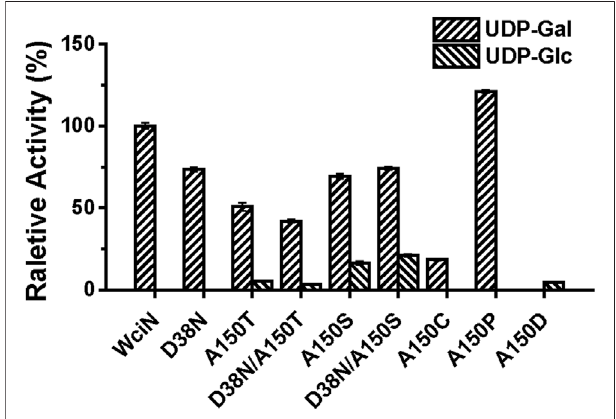
FIGURE4| Relativeactivities ofWciNmutant enzymes towardUDP-Gal and UDP-Glc